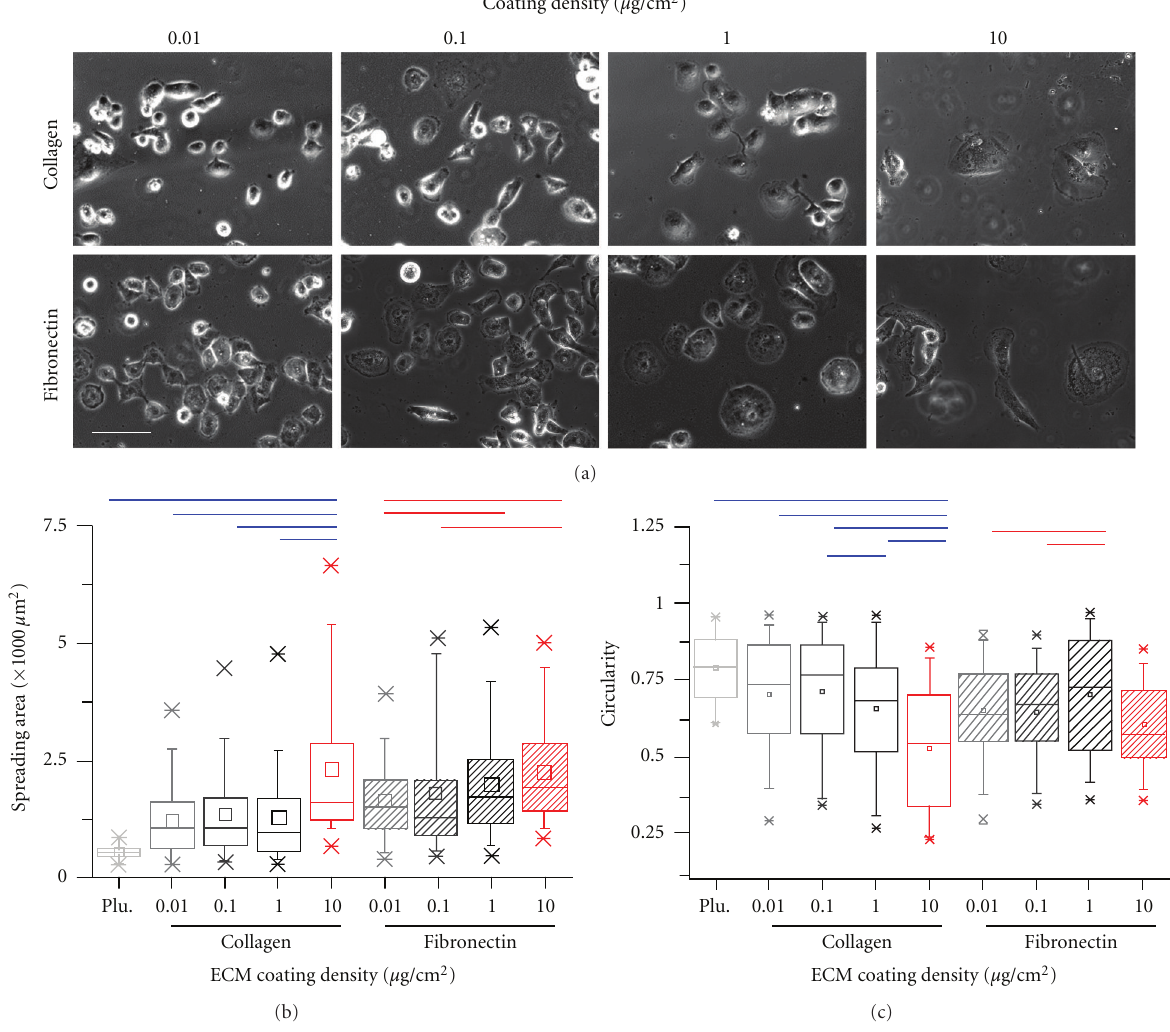
Figure 2: ECM density-dependent cell spreading of MDA-MB-231 cells on collagen- and fibronectin-coated surfaces. (a) Representative phase contrast images of MDA-MB-231 cells cultured on collagen and fibronectin-coated coverslips at di ff erent densities for 24 hours. Scale bar = 100 μ m. (b) Box whisker plots of projected cell area on coverslips coated with collagen or fibronectin at varying densities. Pluronic- blocked coverslips (Plu.) without any matrix coating served as negative controls. Independent of choice of ECM protein, spreading was relatively insensitive to ligand density up to a coating density of 1 μ g/cm 2 and increased thereafter. Bars indicate statistical significance ( ∗ P < 0 . 05). (c) Box whisker plots of circularity measures on coverslips coated with collagen or fibronectin at varying densities. Increase in ECM density was associated with a reduction in circularity on collagen-coated surfaces. Circularity exhibited a biphasic behavior on fibronectin-coated surfaces. Bars indicate statistical significance ( ∗ P < 0 .